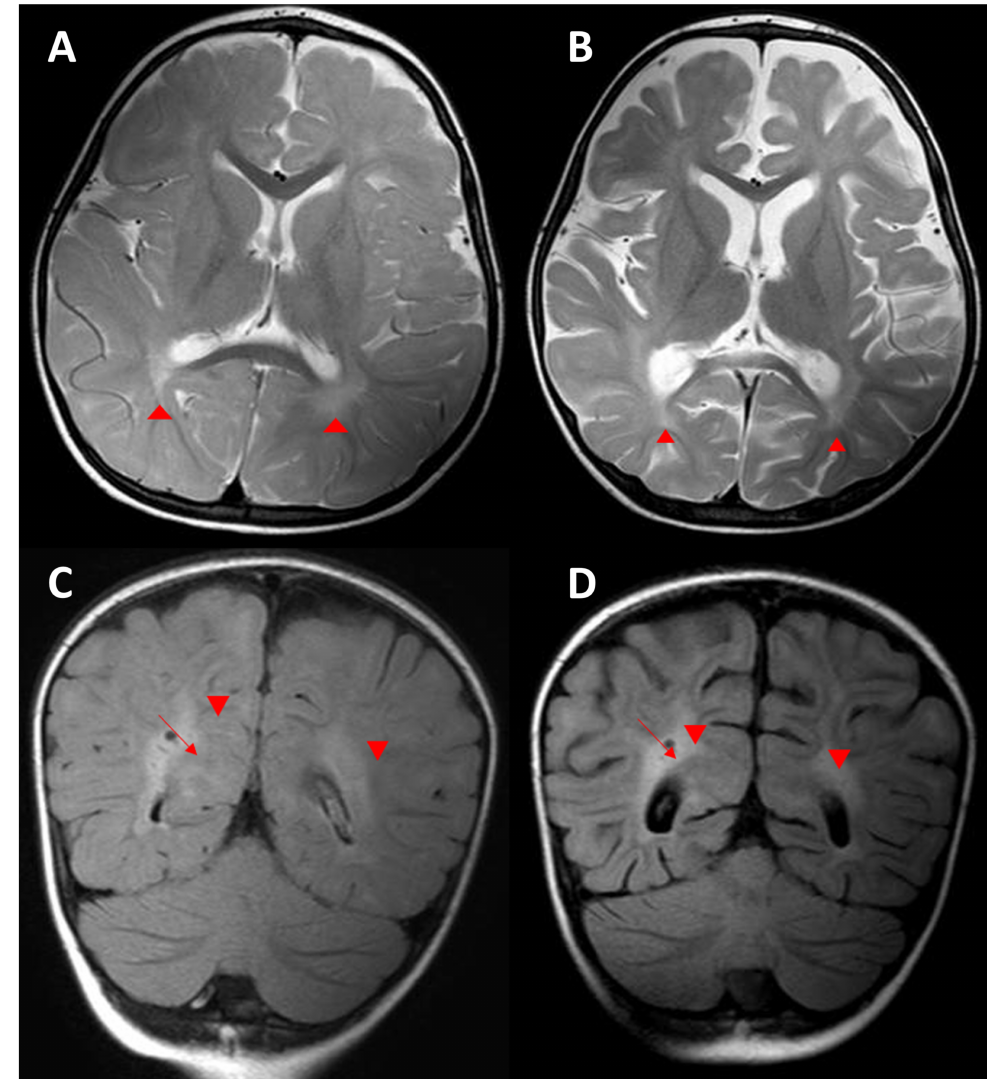
Figure 4. Proband axial brain MRI scans. ( A ) Axial T2 brain MRI showing delayed myelination for the patient’s age with diffuse abnormal high T2 signal intensity seen in the periventricular deep white matter, more prominent in both peri-trigonal regions (arrow heads). There is also prominence of the subarachnoid spaces in both frontal regions. ( B ) Follow-up axial T2 brain MRI demonstrating progressive brain atrophy with unchanged delayed myelination and diffuse abnormally high T2 signal intensity seen in the periventricular deep white matter, more prominent in both peri-trigonal regions (arrowheads). ( C ) Coronal FLAIR brain MRI image demonstrating diffuse abnormally high signal intensity in the periventricular deep white matter, more prominent in both peri-trigonal regions (arrow heads) with prominent VR spaces (arrow). ( D ) Follow-up coronal FLAIR brain MRI demonstrating the progressive brain volume loss with unchanged diffuse abnormally high signal intensity in the periventricular deep white matter, more prominent in both peri-trigonal regions (arrowheads) with prominent VR spaces